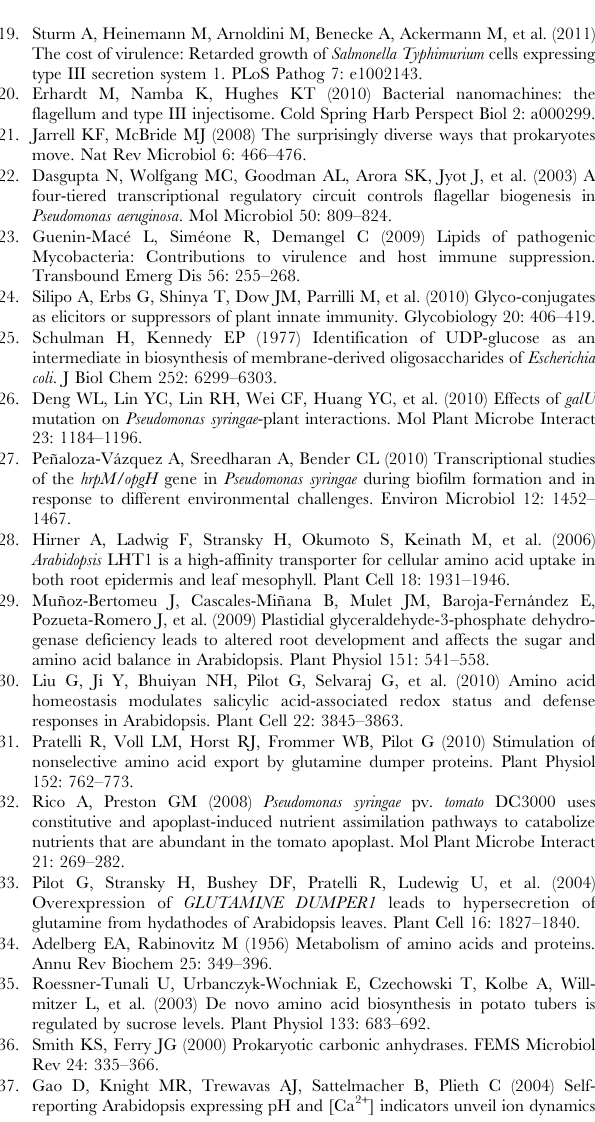
Figure S3 Macroscopic symptoms following high-dose inoculation of Arabidopsis ecotype Eilenburg-0 with Pma ES4326. Half of each leaf was inoculated with